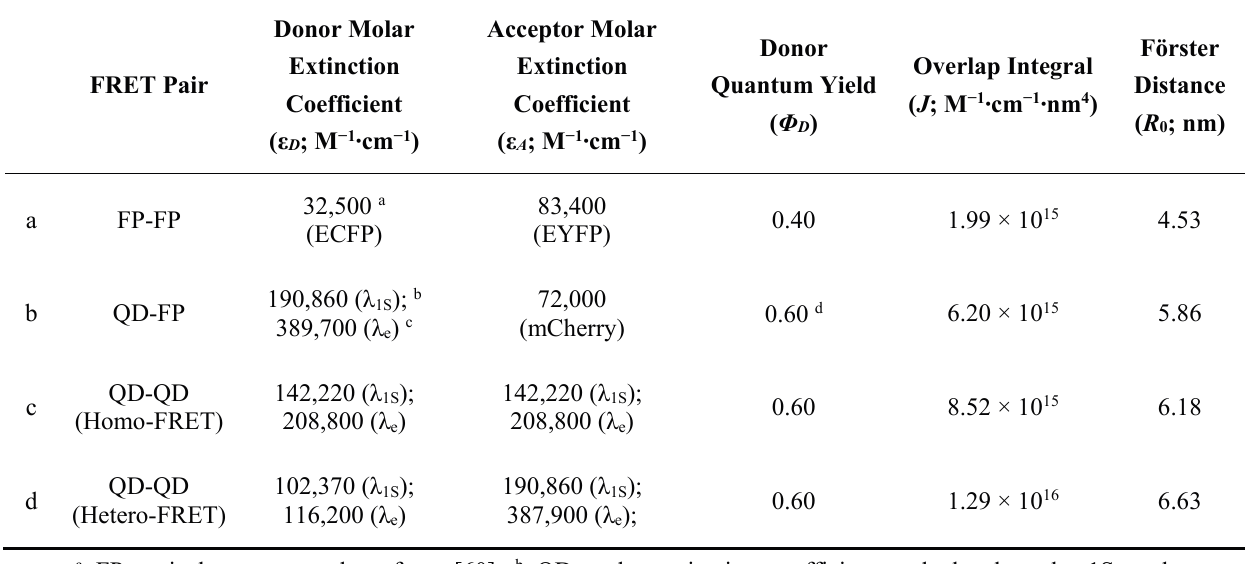
Table 1. Optical properties for the FRET pairs depicted in Figure